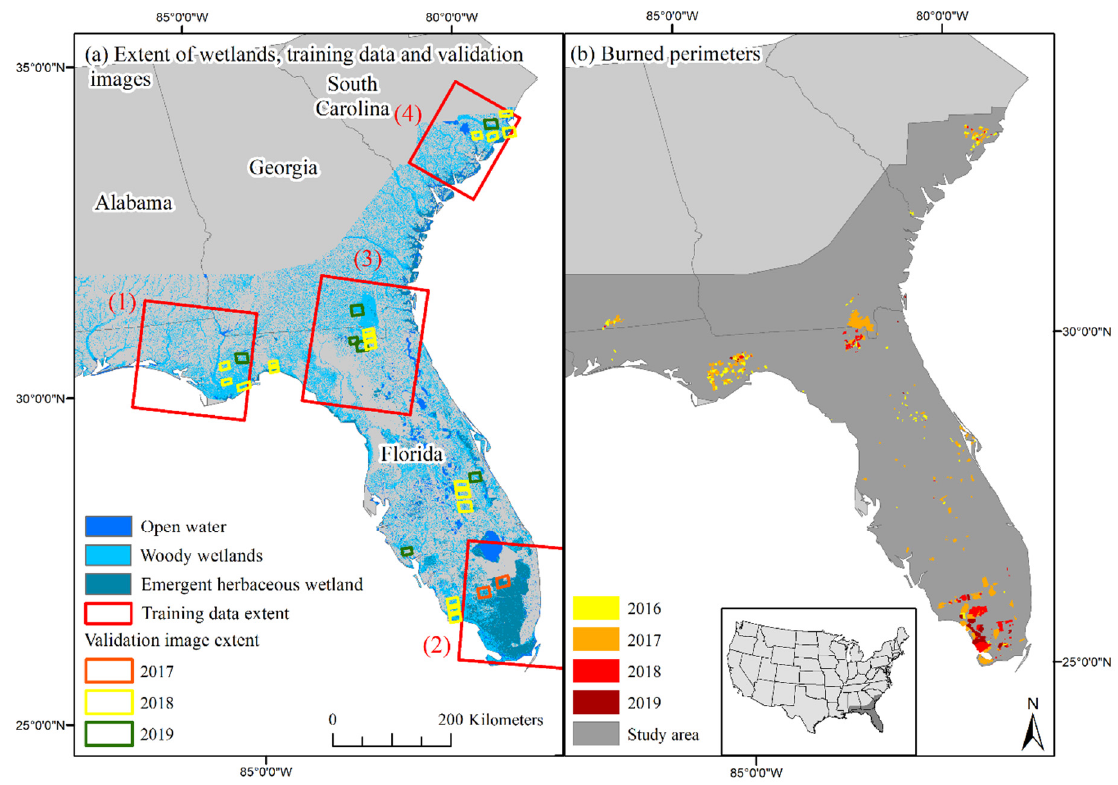
Figure 2. Distribution of ( a ) National Land Cover Database (2016) wetland and water classes, extent of training data, and distribution of validation images, and ( b ) burn perimeters by fire year. Training data extent are shown in red boxes and labeled as the ( 1 ) Florida panhandle, ( 2 ) Florida Everglades, ( 3 ) Eastern Florida–Georgia border, and ( 4 ) coastal plains of South Carolina.